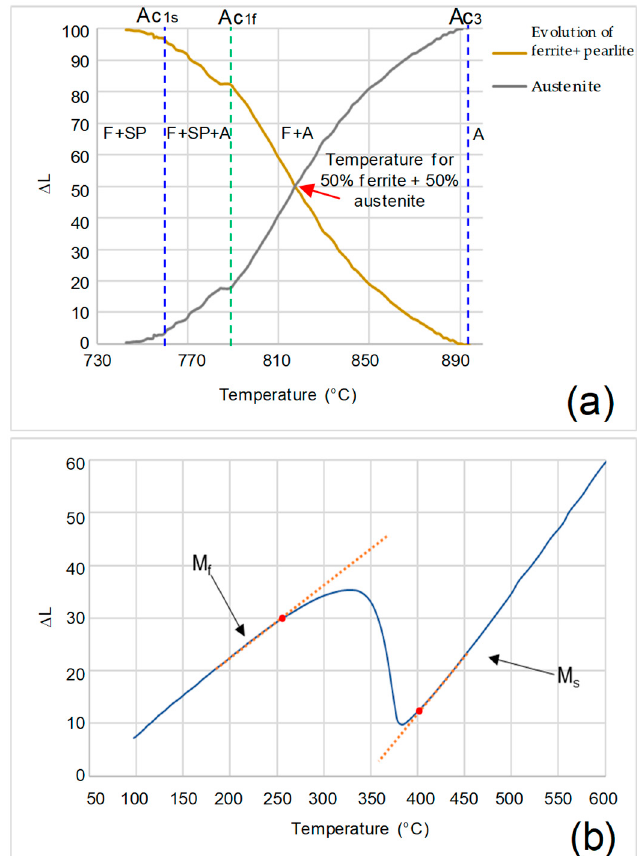
Figure 5. ( a ) Evolution of α -ferrite (F), second phases (SP) and γ -austenite (A) during continuous heating, showing the temperature needed to achieve 50% α + 50% γ ; ( b ) dilation curve obtained during continuous cooling of cold-rolled steel as a function of temperature.